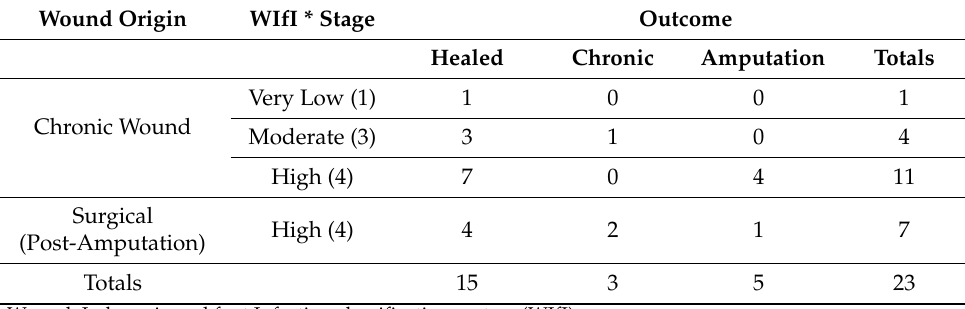
Table 3. Wound healing outcomes stratified by wound origin and WIfI *